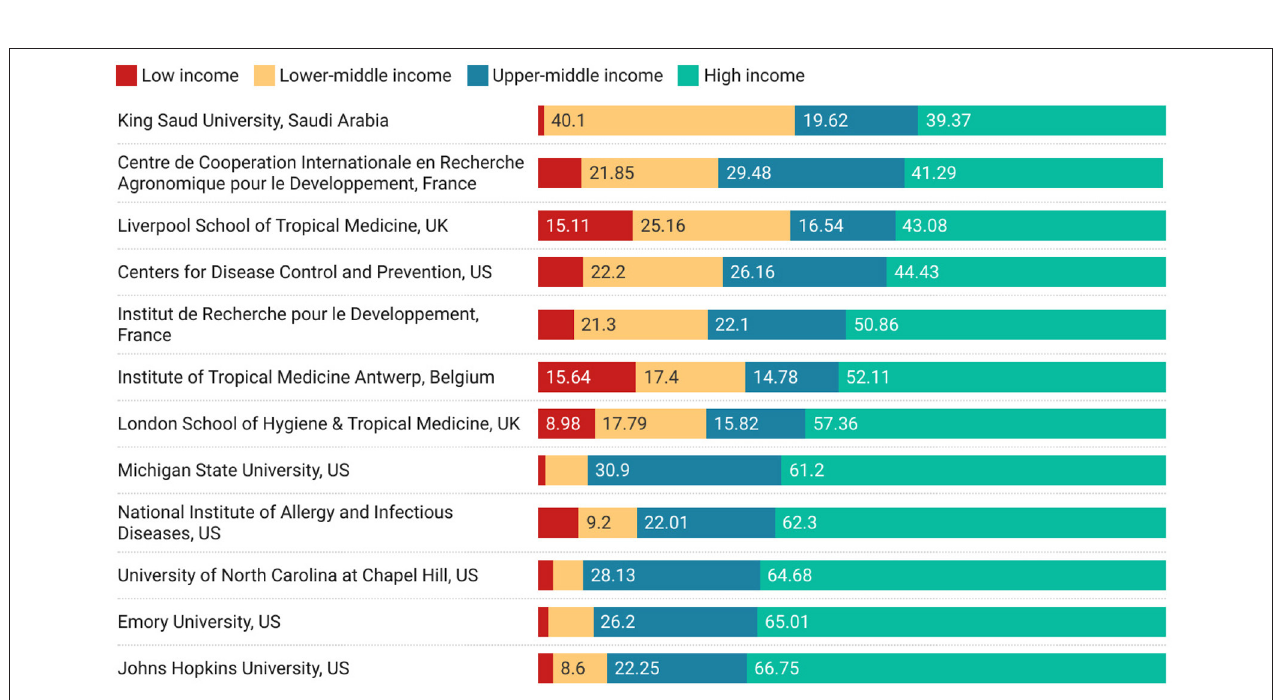
FIGURE 5 | Top 12 High-income-country research institutions with highest non-high-income collaborations.